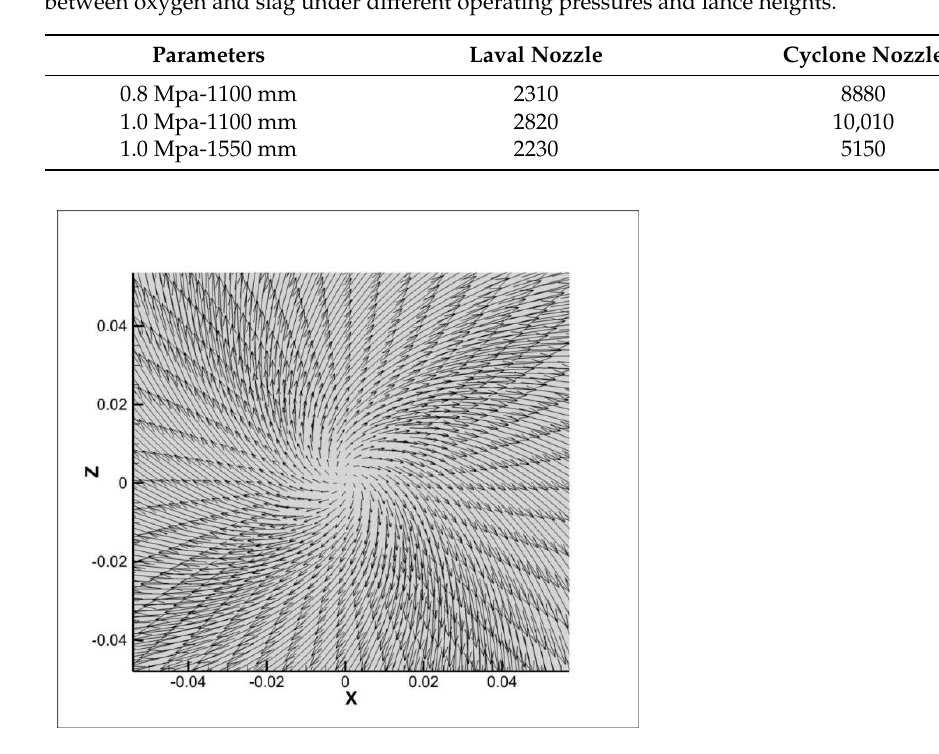
Table 4. The average value of the turbulent kinetic energy of Laval and cyclone nozzle at the interface